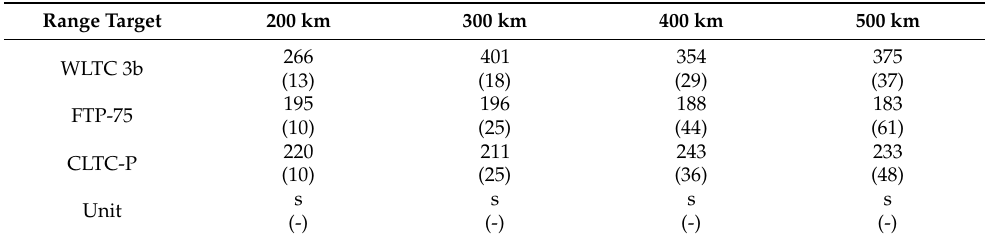
Table A3. Average REX single instance running time and the total number of engagements (in parentheses) for four range targets in WLTC 3b, FTP-75, and CLTC-P drive cycles. Vehicle mass is 1800